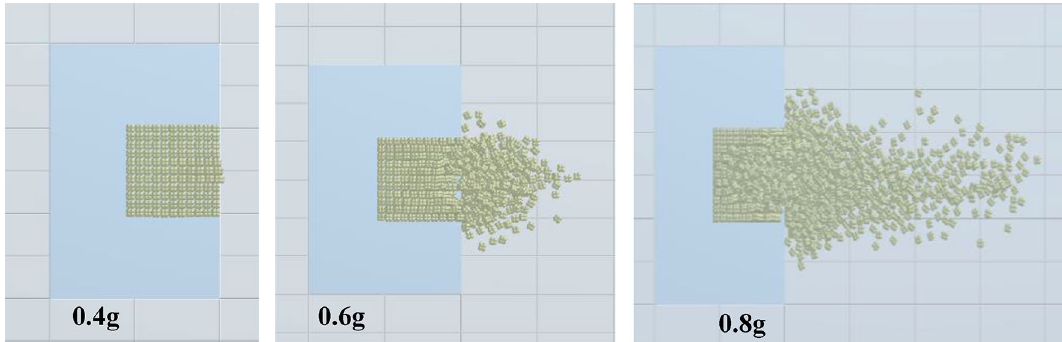
Figure 15. The final accumulation of block particles under different charges from the top